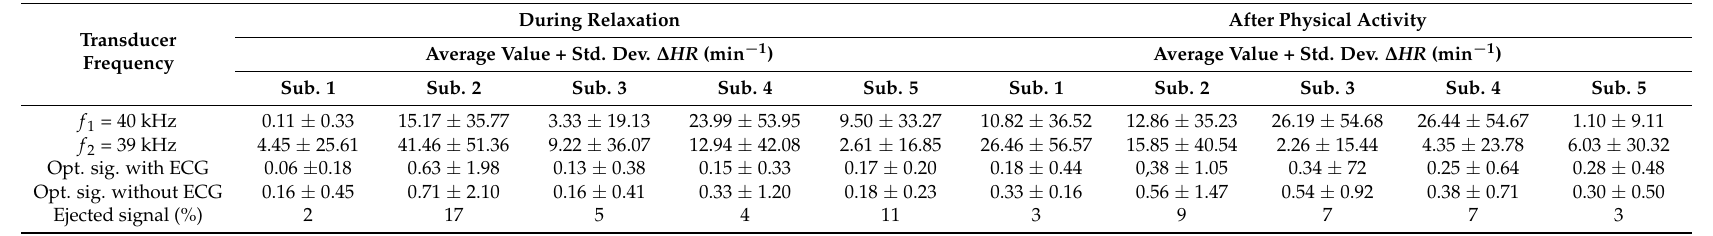
Table 2. HR statistical parameters for laboratory experiment, subject 1–5.